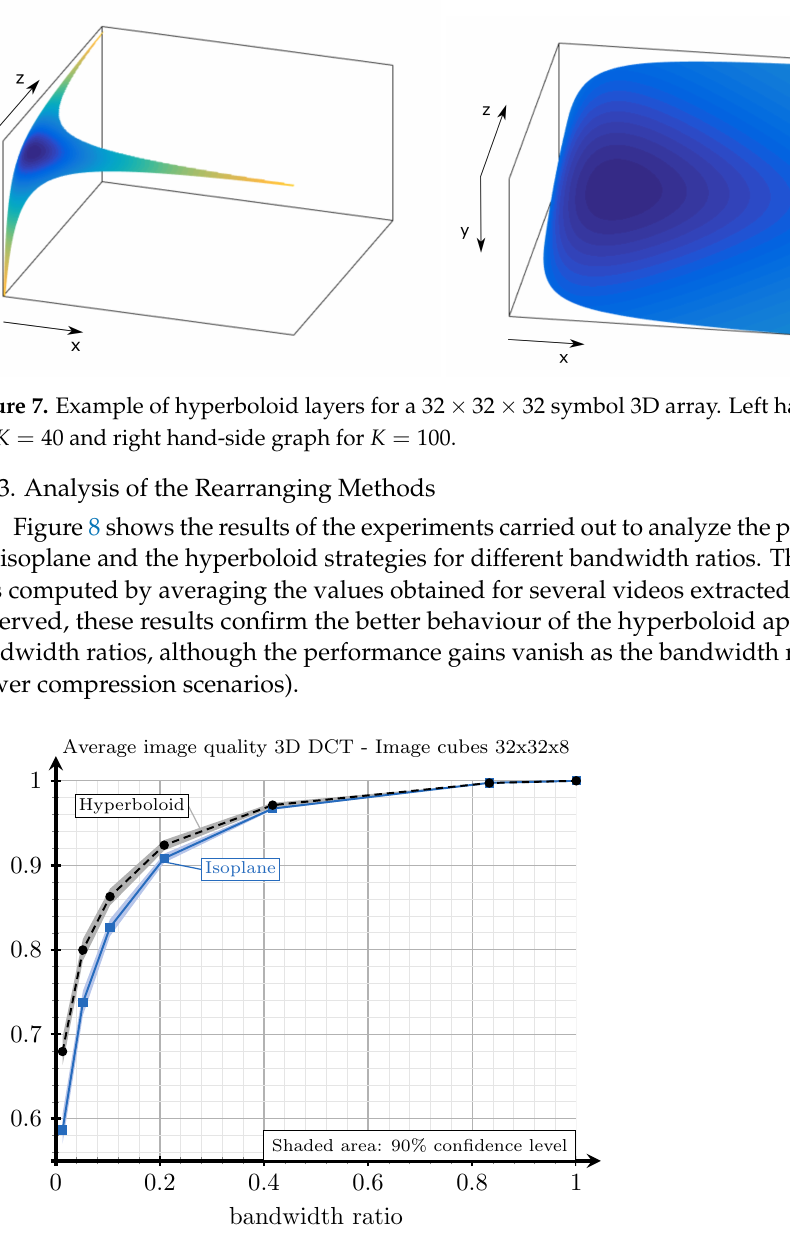
Figure 8. SSIM versus bandwidth ratio for the isoplane (blue line) and the hyperboloid (black dashed line) strategies to arrange the coefficients at the output of the 3D-DCT. The results are averaged considering four videos extracted from